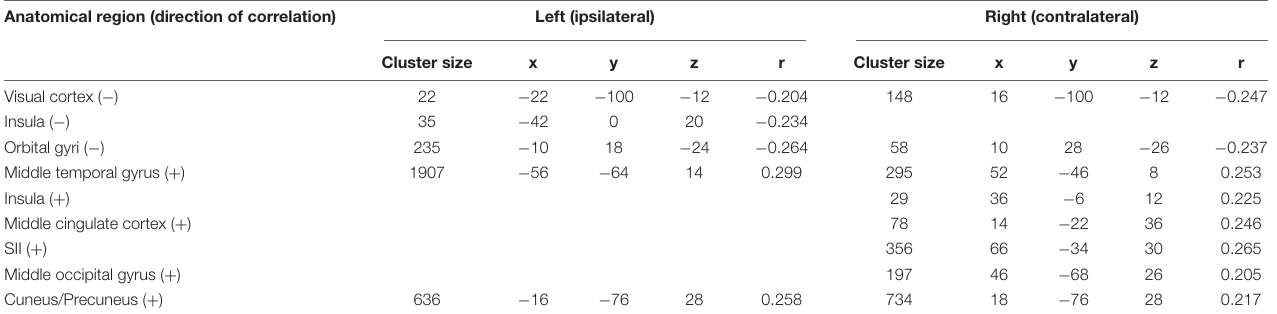
Middle occipital gyrus ( +